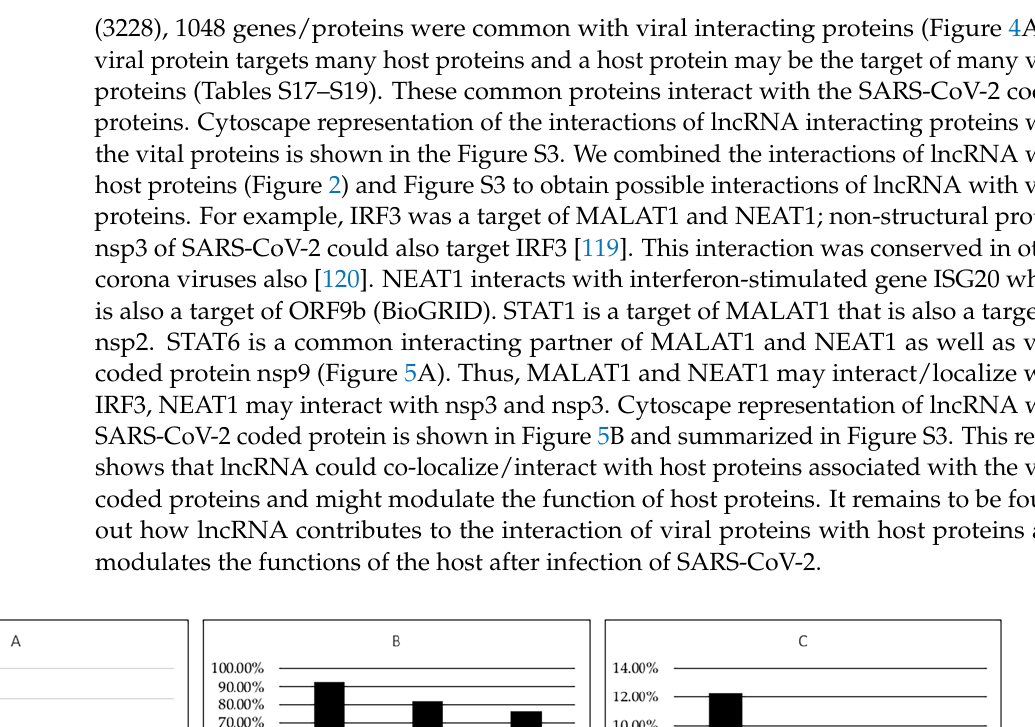
Figure 5. ( A ): Specific examples of indirect interaction of lncRNA (shown by the broken lines) with the viral proteins by localizing/interacting with common host proteins. ( B ): Cytoscape representa- tion of lncRNA-viral protein interactions based on the interaction of lncRNA-genes/proteins from Figure 2 and proteins coded by the virus and lncRNA interacting proteins (Figure S3). 3.1.4. Host Genes Involve in SARS-CoV-2 Infection as Determine by Genome-Wide CRISPR Loss-of-Function Screens and Their Interactions with Deregulated lncRNA Genome-wide CRISPR loss-of-function screens identified 6248 genes to modulate SARS-CoV-2 infection [100–107]. We downloaded the data from BioGRID and compared